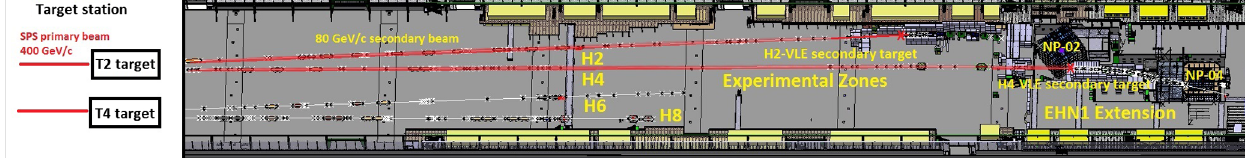
FIG. 1. A schematic layout of EHN1, the largest experimental hall of SPS secondary beam facilities. As explained in the text, the primary beam from SPS is slowly extracted on the primary (T2) target. Subsequently, the secondary 80 GeV =c beam is momentum- selected and transported to the newly constructed secondary targets, in order to produce the low energy particles. The newly designed H2-VLE and H4-VLE beam lines select and transport these low energy particles to NP-02 and NP-04